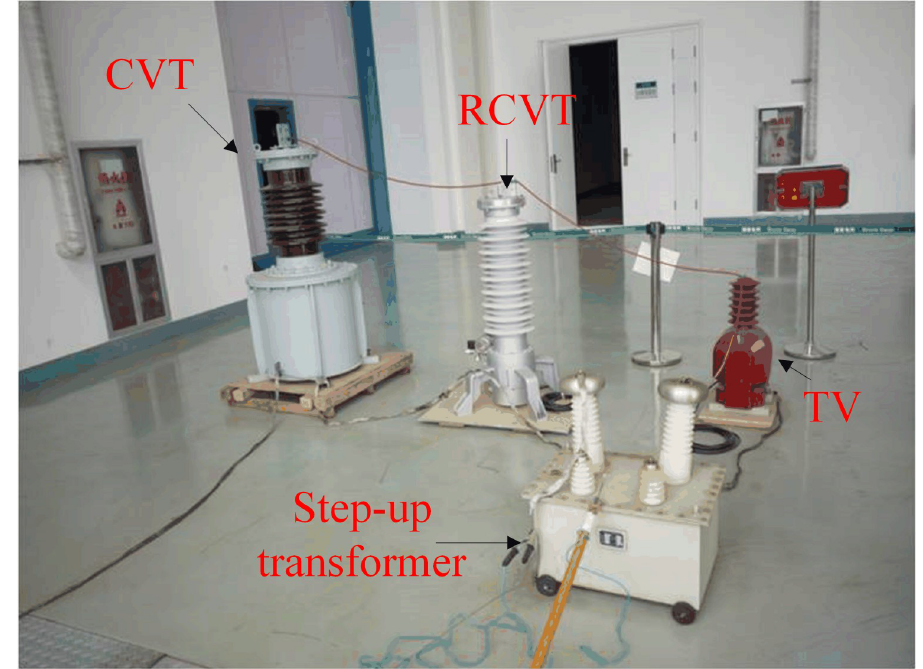
Fig 10. Arrangement of part of the experimental setup.